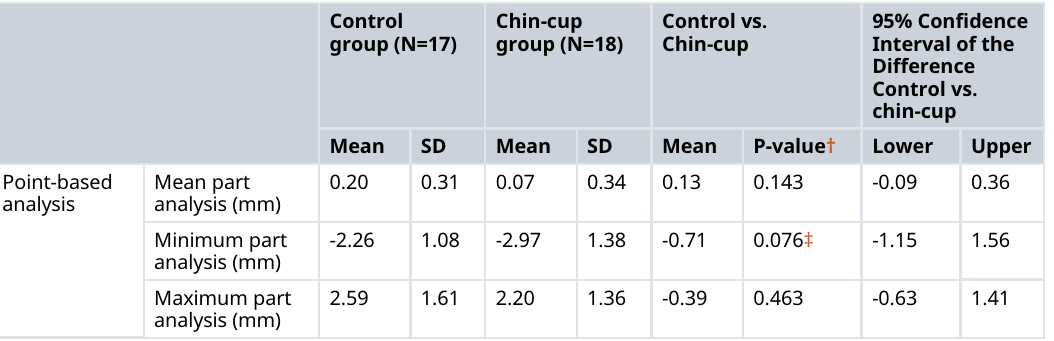
Table 7. Descriptive statistics of quantitative displacement parameters of the superimposed 3D models (T2-T1) as well as the p-values of significance